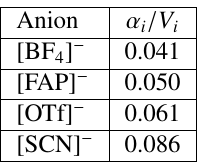
Fig. 1 the polarizability as a function of the chain length for both [C k mim] + and [uC k mim] + families, which only di ff er in the conjugated character of their chains.